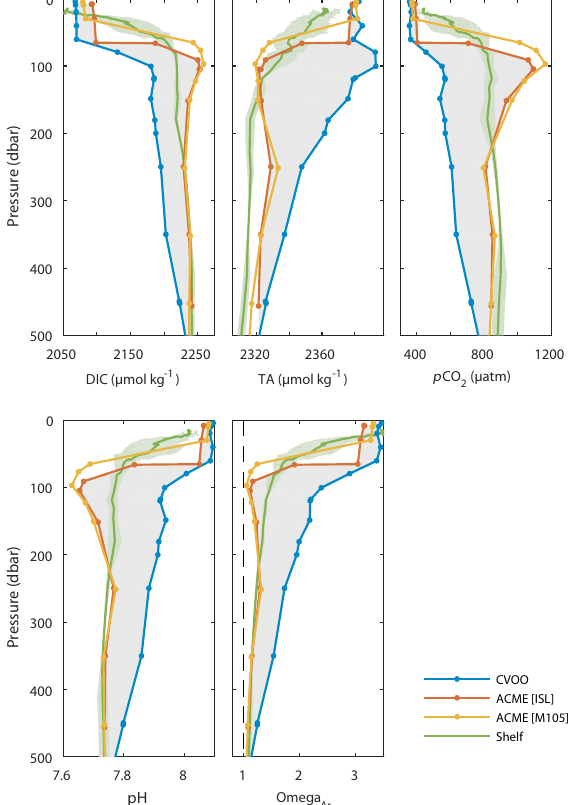
Figure 5. Discrete bottle data for DIC and TA and calculated pa- rameters of the carbonate system (pH, p CO 2 and (cid:127) Ar ) from the different ACME surveys. The gray shading illustrates the anomaly of the ACME (ISL) with respect to the regional background situa- tion